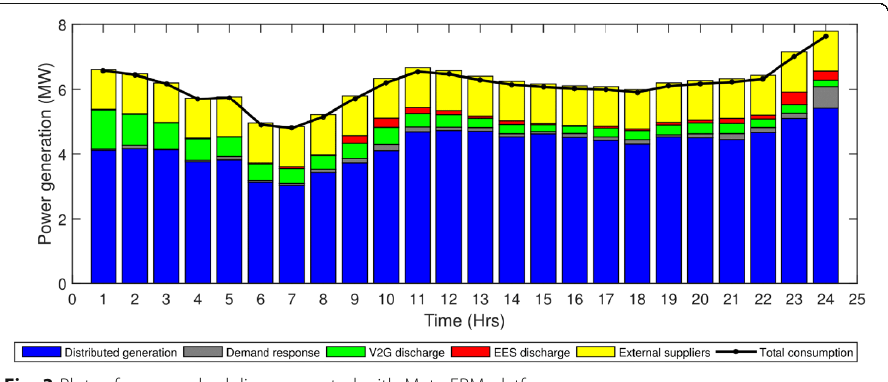
Fig. 3 Plots of power scheduling generated with Meta-ERM